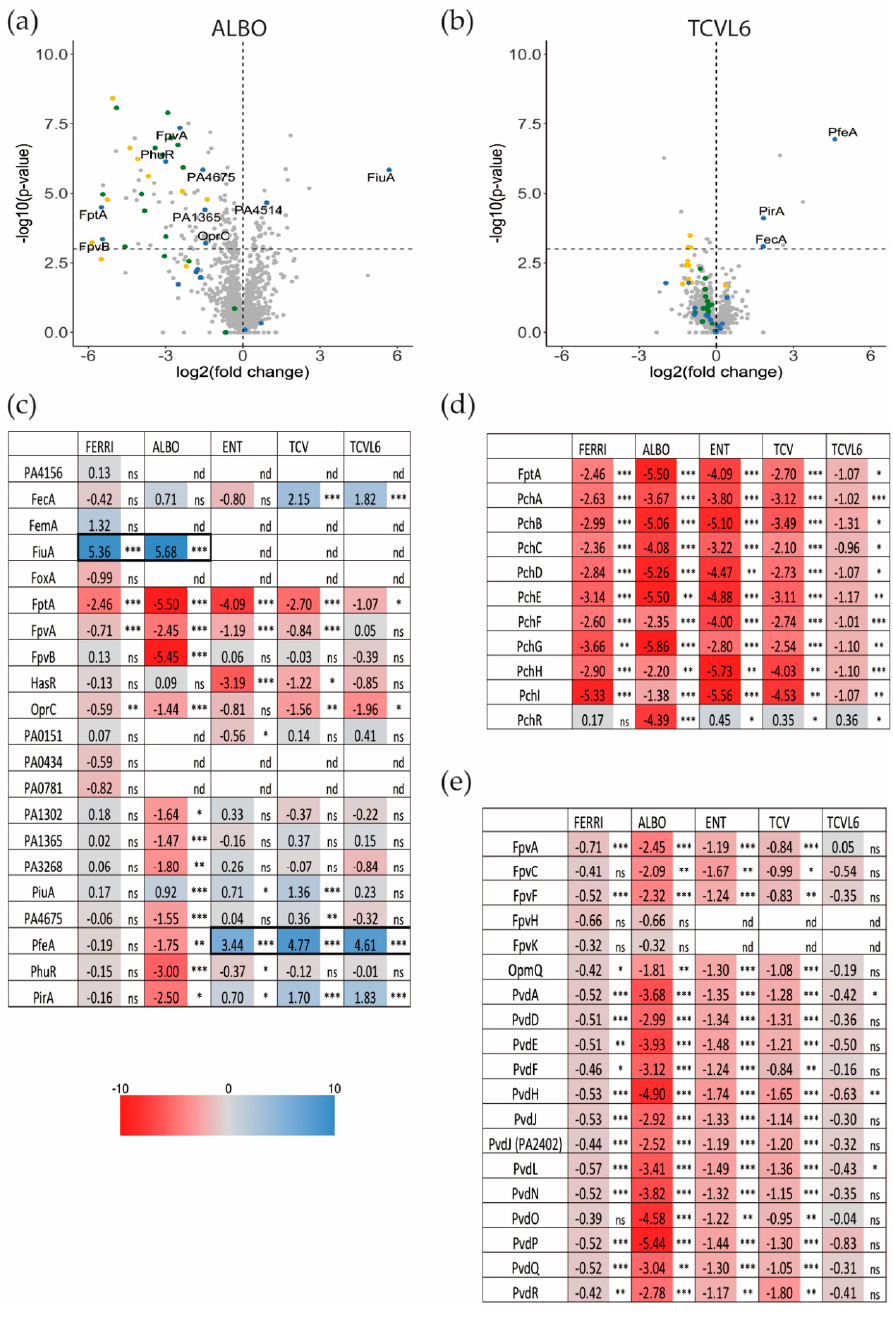
Figure 5. Analysis of changes in the expression of proteins involved in iron-uptake pathways in P. aeruginosa cells during A549 epithelial cell infection, in the presence or absence of ALBO,